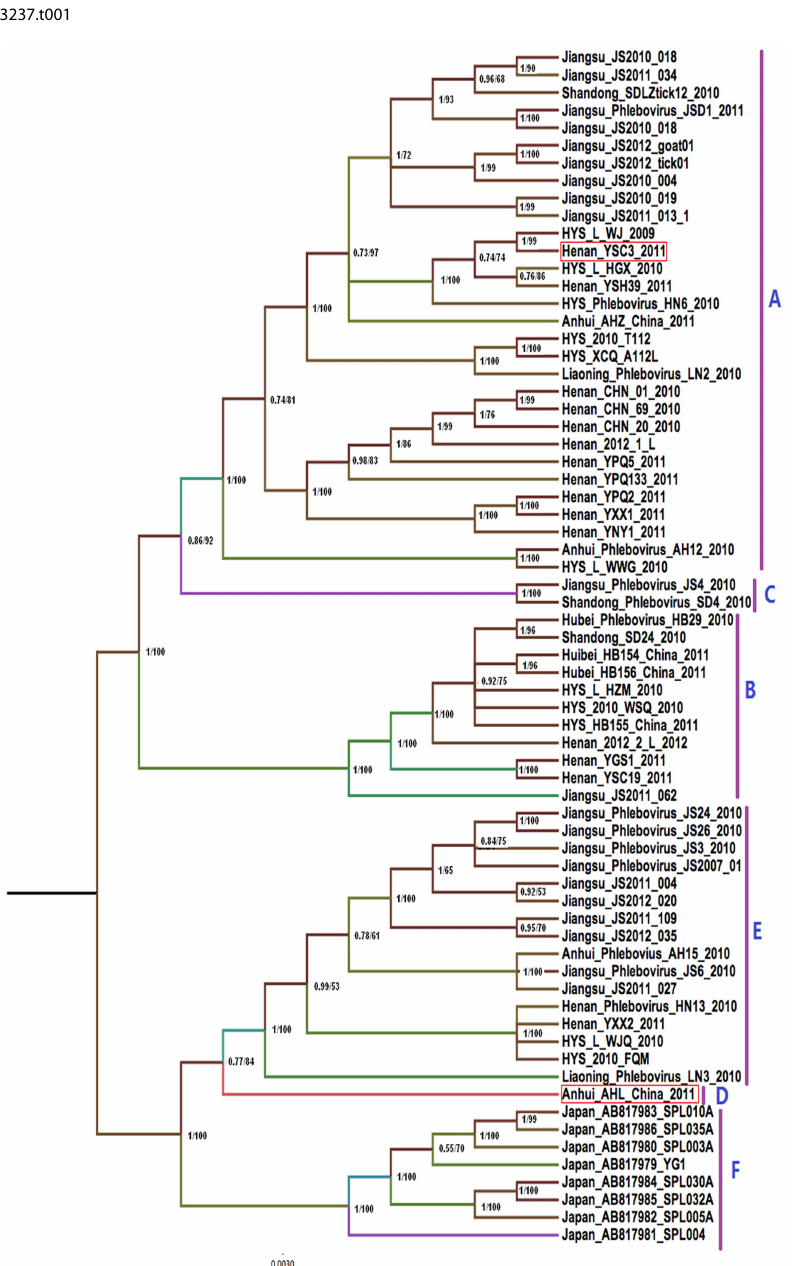
Figure 1. Bayesian coalescent and Maximum likelihood (ML) analysis of FTLSV based on the L segment. Maximum clade credibility and Maximum likelihood tree is shown with posterior probability values and bootstrap value depicted at the nodes. Phylogenetic analysis was carried out using Mrbayes 3.2.1 and Mega software 5, respectively. Designations of the different FTLSV phylogroups (A B,C,D,E,F clade) are as indicated, based on previously defined assignments. These sequences are described in more detail in Table 1. The sequences from Japan were included in this analysis.